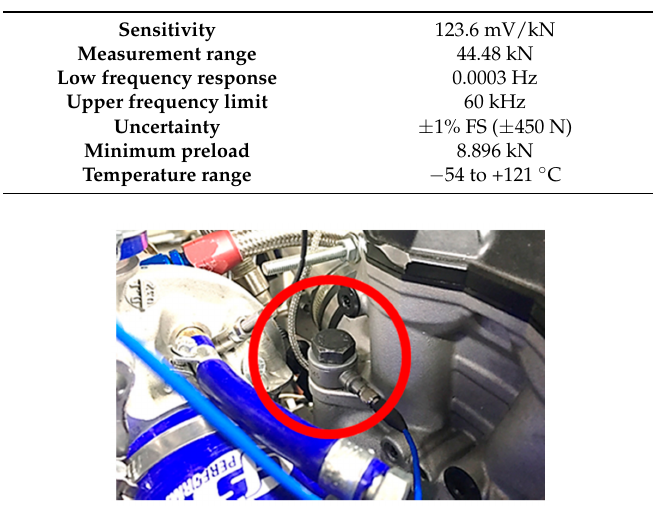
Table 2. Strain washer main features.